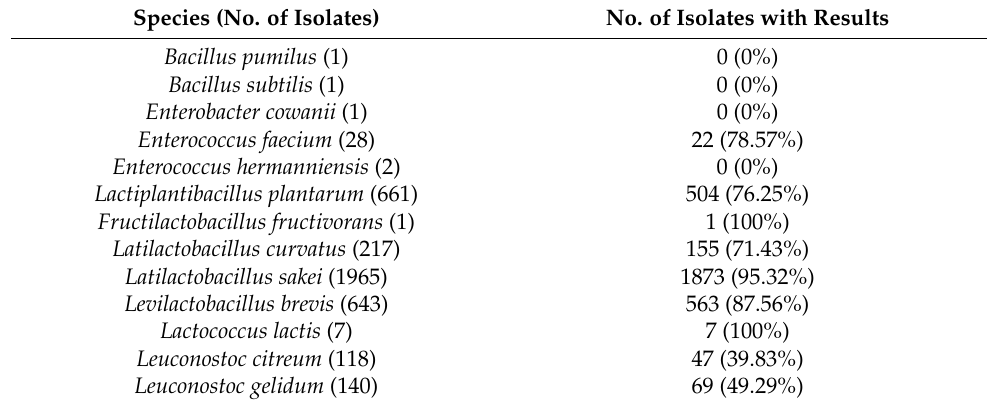
Table 1. Number of isolates with correct identification to the species level by MALDI-TOF MS. Species (No. of